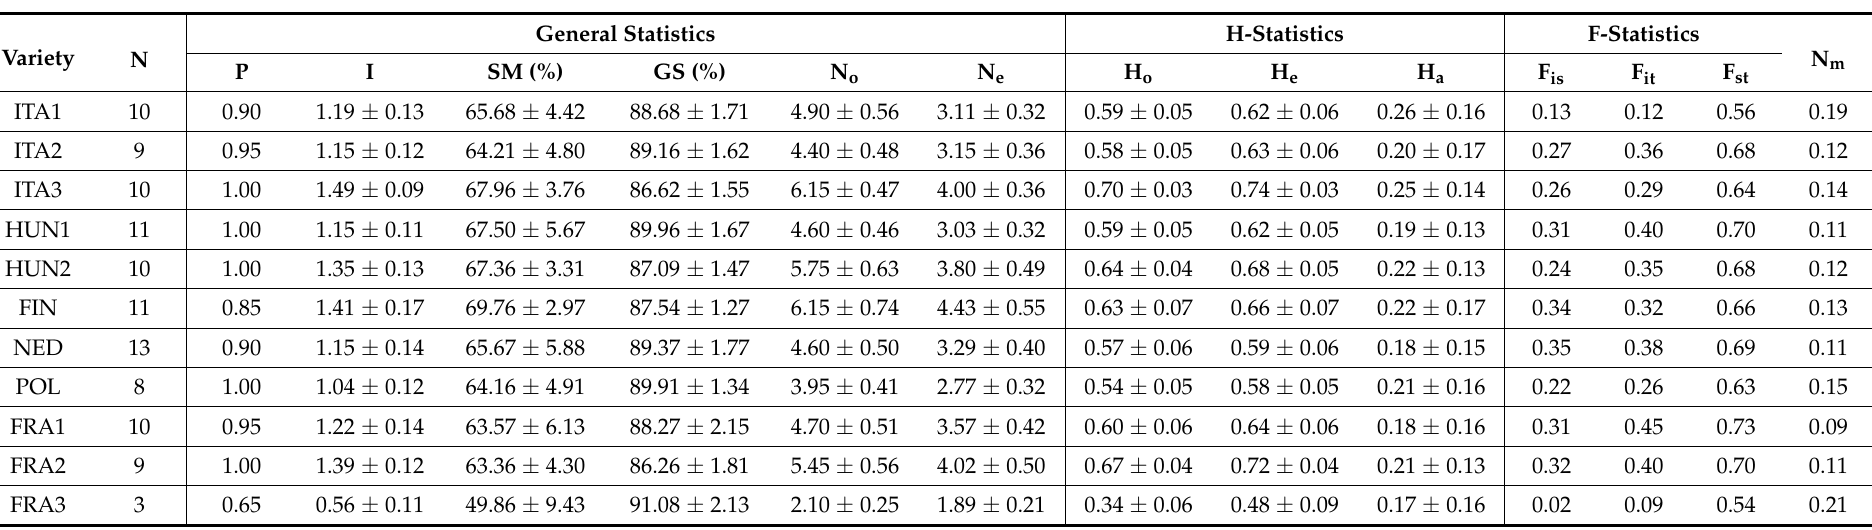
Table 2. Descriptive genetic diversity statistics of the Cannabis accessions calculated for individual varieties, including heterozygosity degrees, similarity degrees, inbreeding coefficients, and gene flow